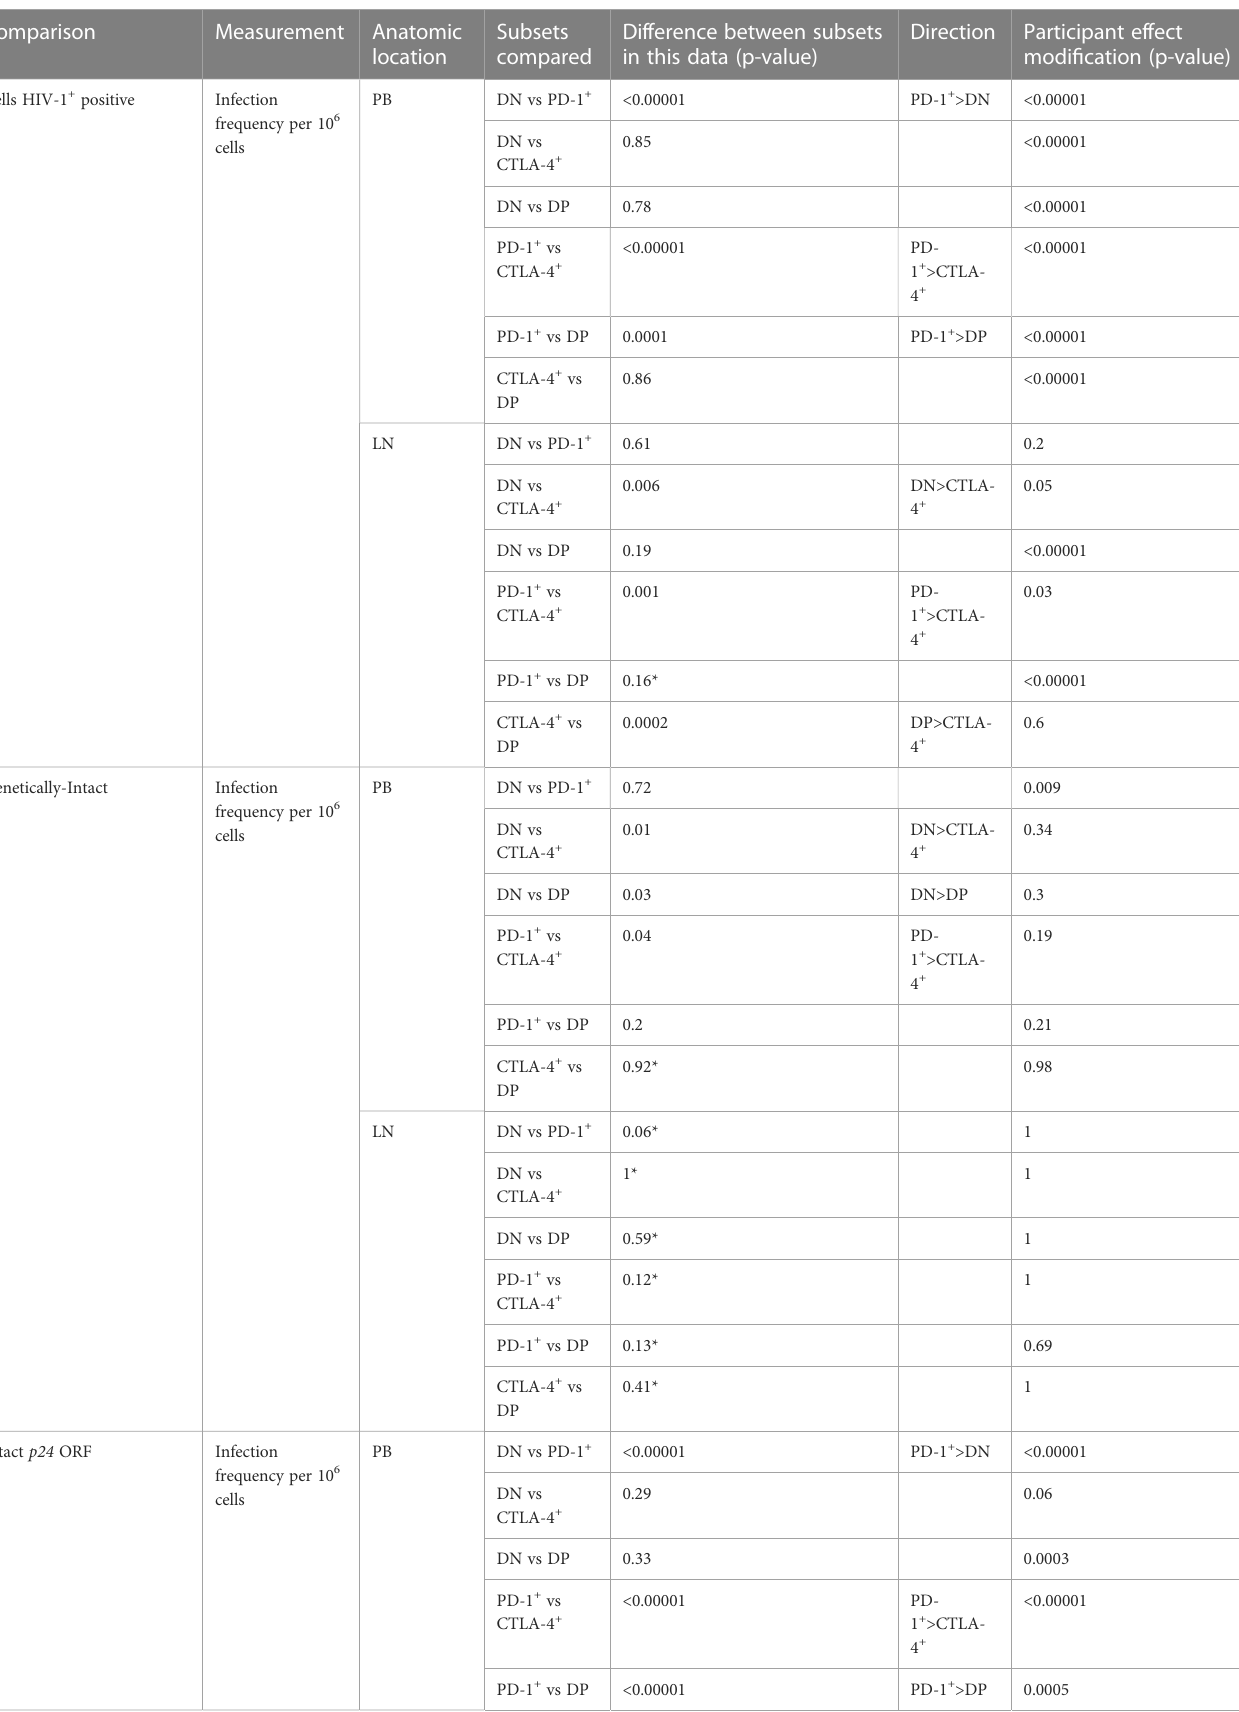
TABLE 1 Calculated p-values indicating differences in speci fi c properties of HIV-1 proviruses between subsets or participant effect modi fi